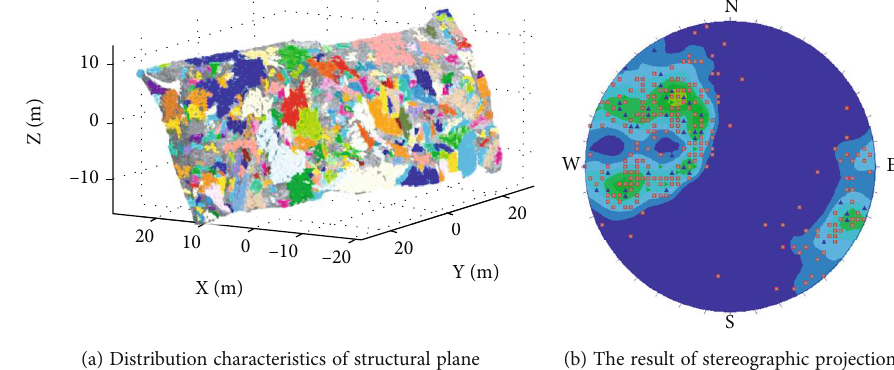
Figure 6: Distribution characteristics of structural plane and the result of stereographic projection.